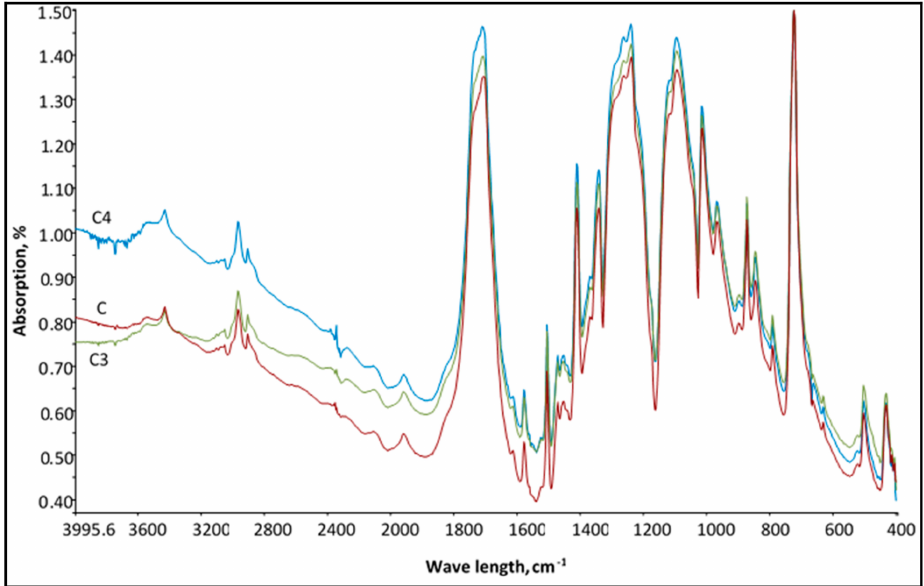
Figure 5. FTIR spectrum of samples C , C3 and C4 .